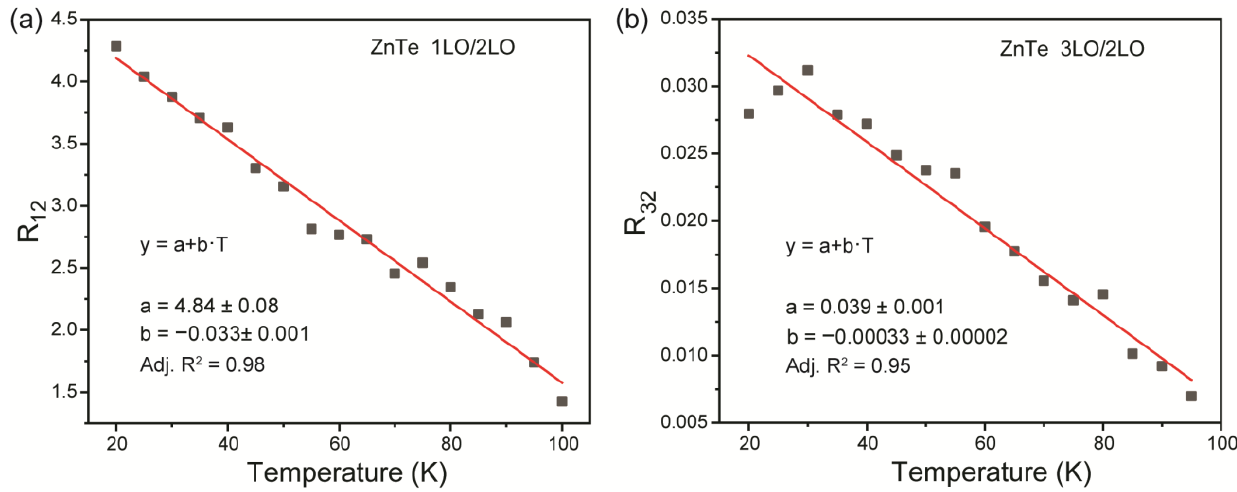
Figure 2. Temperature evolution of ( a ) R 12 and ( b ) R 32 .